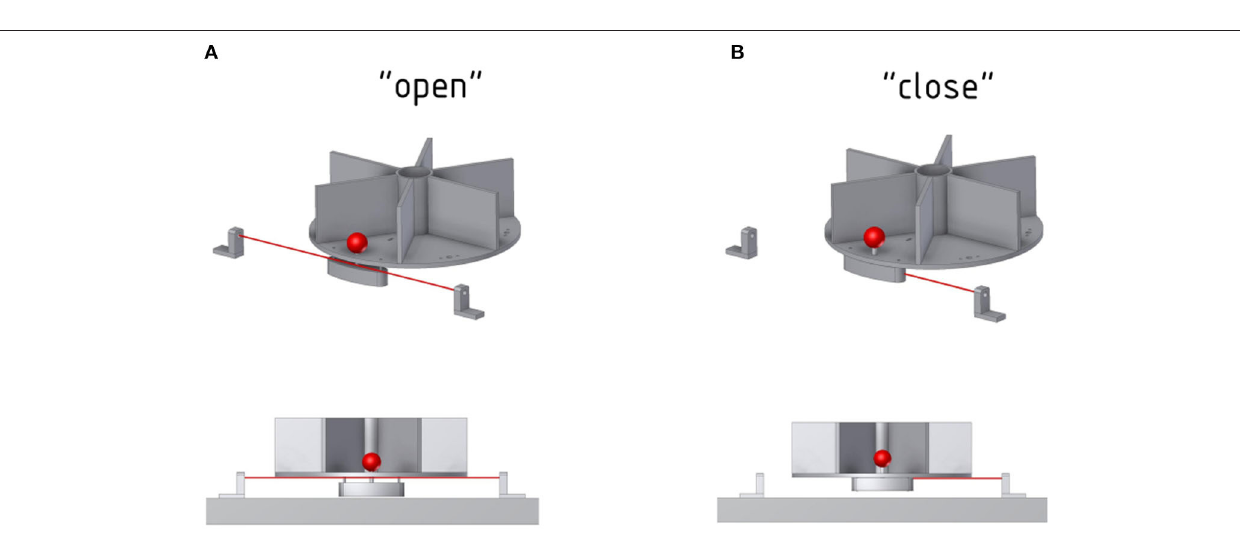
FIGURE 5 | Function of the photoelectric Laser barrier. To determine whether an object has been lifted, a Laser and photoelectric element is placed below the object. (A) The Laser can pass through as long as the object is not lifted. (B) The counterweight of the front object will block the Laser once the object is